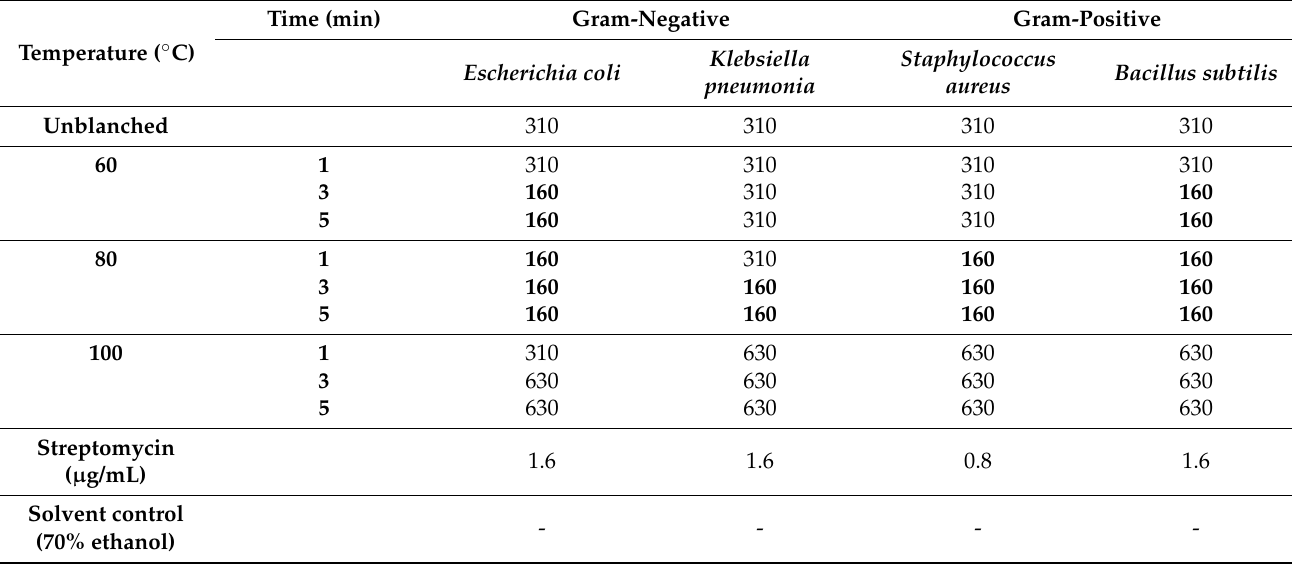
Table 4. Antibacterial activity (MIC, µ g/mL) of ethanol (70% ( v/v )) extracts from blanched (60, 80 and 100 ◦ C for 1, 3 and 5 min) ‘Wonderful’ pomegranate peel